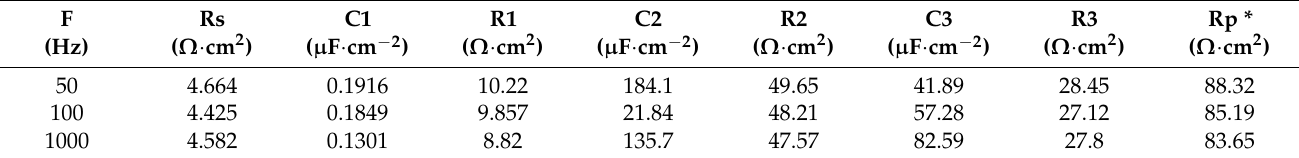
Figure 11. The equivalent circuit used to fit the Nyquist plot in Figure 9. Table 3. Impedance parameters.